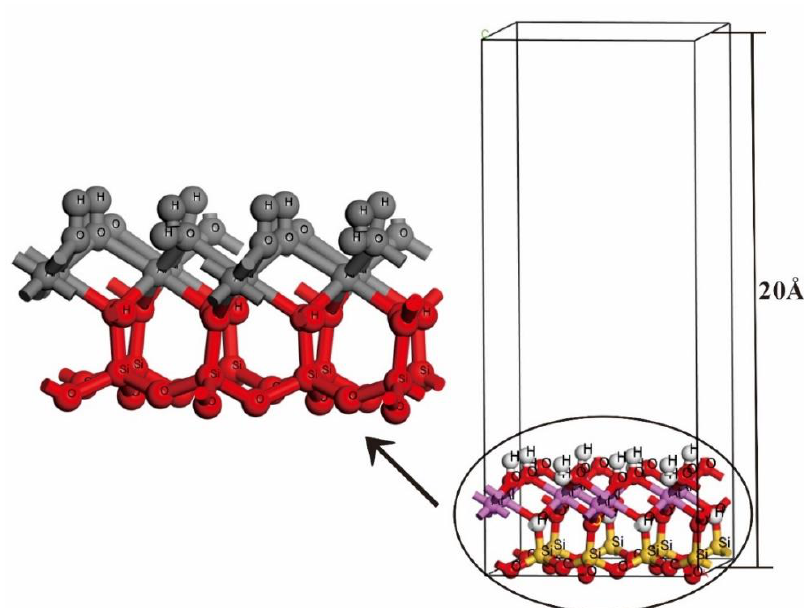
Figure 2. A vacuum layer of 20 Å was created on the surface of kaolinite (001). The left part is an enlarged kaolinite, in which red is a fixed three sub-layers and gray is a relaxed three sub-layers.